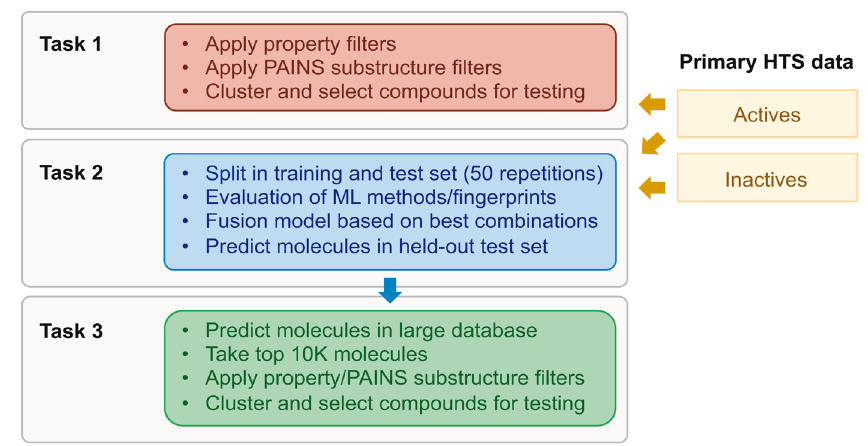
Figure 1. Schematic representation of Workflow